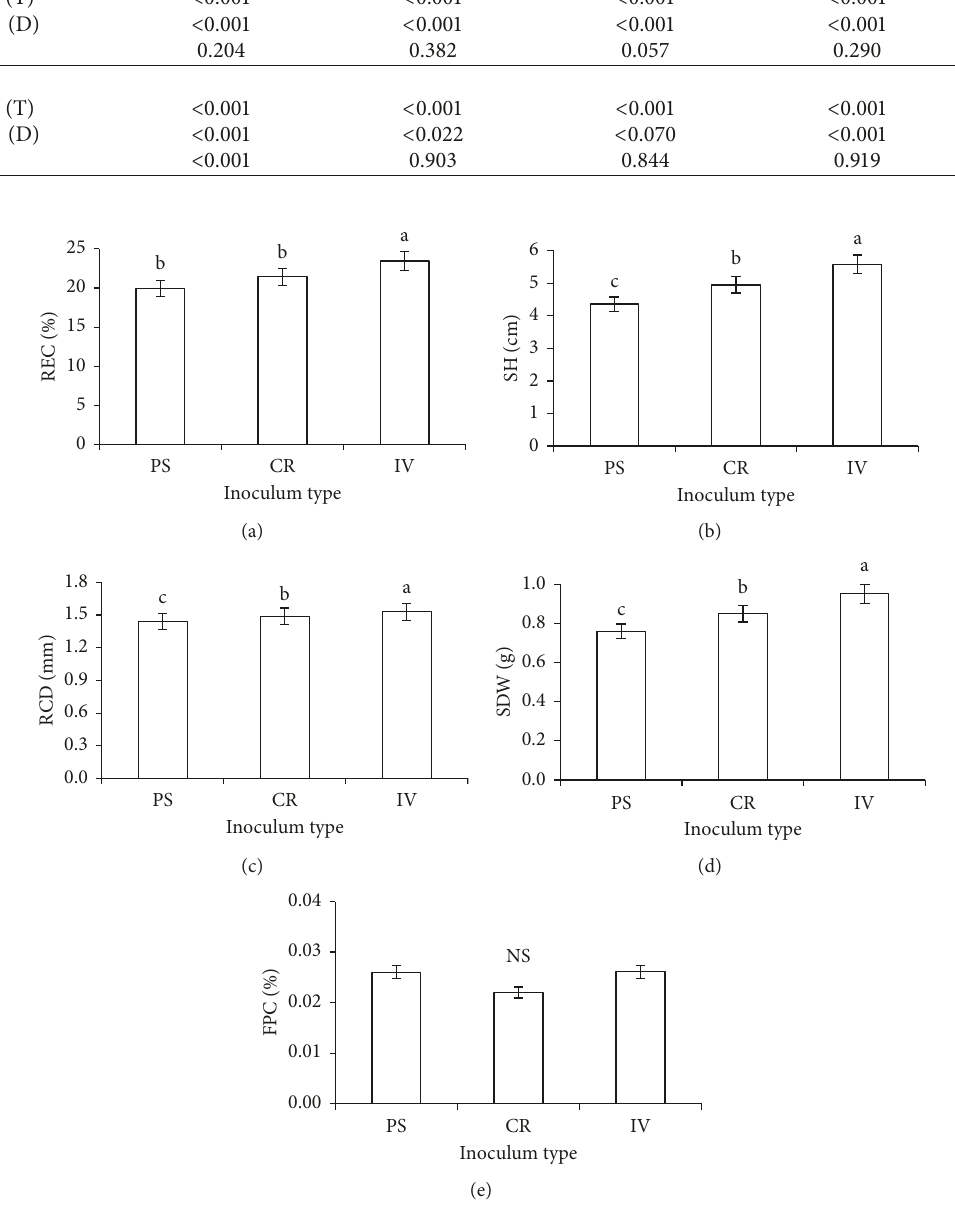
Figure 1: (a) Root ectomycorrhizal colonization (REC), (b) shoot height (SH), (c) root collar diameter (RCD), (d) shoot dry weight (SDW), and (e) foliar P content (FPC) of P. patula seedlings as a function of inoculum type. Bars indicate standard error. Columns with different letters indicate significant difference ( P 0 . 05) according to the multiple range test of Duncan. NS ≤